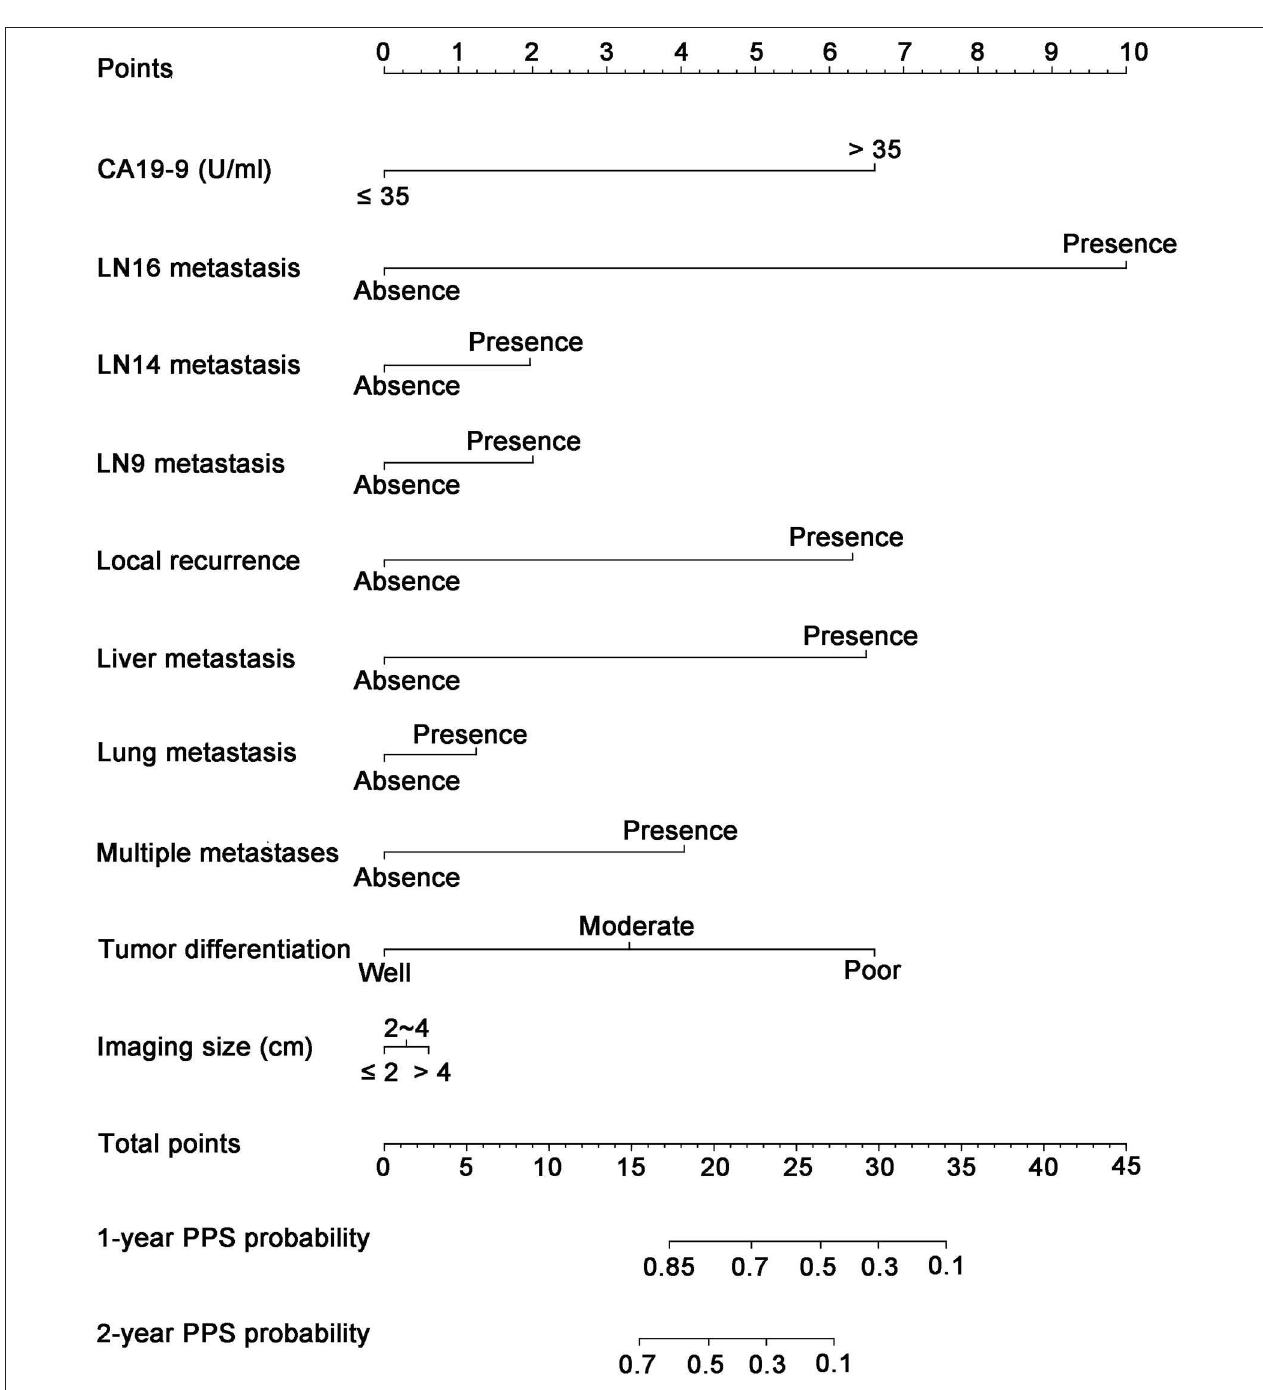
FIGURE 3 | Nomogram for predicting the 1- and 2-year post-progression survival rates in patients with post-operative recurrence of PDAC. PDAC, pancreatic ductal adenocarcinoma.